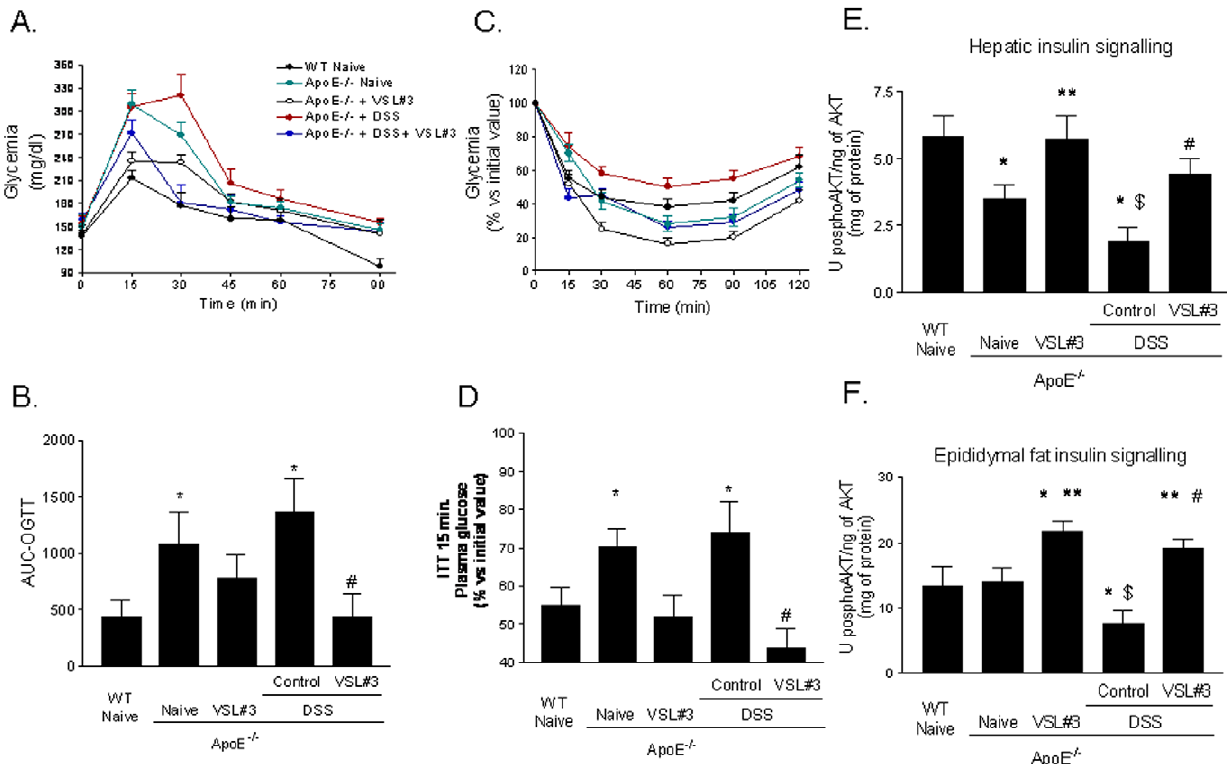
Figure 1. VSL # 3 administration reverts insulin resistance in ApoE 2 / 2 mice: effect on OGTT, ITT and insulin signaling. ApoE 2 / 2 mice were administered daily with VSL # 3 alone or in combination with DSS for 12 weeks starting at the age of 8–9 months. The OGTTs were performed after 10 weeks of treatment. A ) Blood glucose levels in response to OGTT. B ) Area under the OGTT curve (AUC) from 0 to 120 min after glucose administration: all curves were adjusted by subtracting the initial glucose values from actual glucose measurements. The ITTs were performed after 11 weeks of treatment, the data were expressed as % of basal glucose values . C ) The ITTs were performed. D ) illustrates glucose plasma levels after 15 minutes of insulin administration. Mean 6 SE is plotted; n=8–12 mice per group. Effect of VSL # 3 administration on AKT Ser(473) phosphorylation in ( E ) liver and ( F ) epididymal fat tissues. Data are means 6 SE of n=8 mice per group. * p , 0.05 ApoE 2 / 2 experimental group versus naive wild type group; ** p , 0.05 ApoE 2 / 2 naı¨ve group versus ApoE 2 / 2 plus VSL # 3 group; $ p , 0.05 ApoE 2 / 2 naive group versus ApoE 2 / 2 plus DSS group; # p , 0.05 ApoE 2 / 2 plus DSS group versus ApoE 2 / 2 plus DSS and VSL # 3 group.